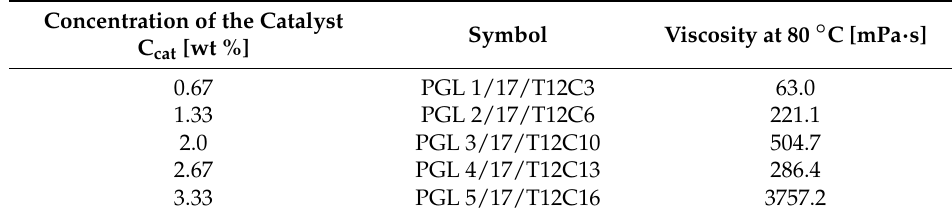
Table 1. Results of glycerol oligomerization reaction catalyzed by sodium carbonate; process conditions: 230 ◦ C, 400 mbar and 12 h